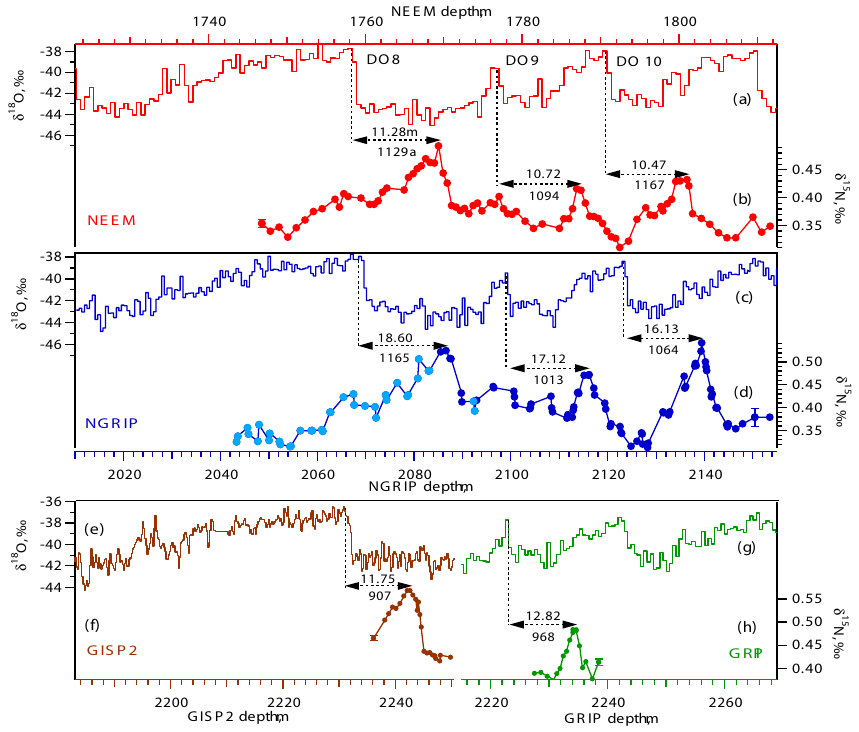
Fig. 2. Water and nitrogen stable isotope data (‰) for NEEM, NGRIP, GISP2 and GRIP. For each δ 15 N data series the associated uncertainty ( ± 1 σ ) is shown. NEEM: (a) δ 18 O bag data (measured along 55cm samples) measured at CIC, this study; (b) δ 15 N data measured at LSCE, this study. NGRIP: (c) δ 18 O bag data, NGRIP members (2004); (d) δ 15 N data measured at the University of Bern. Dark blue: data points from Huber et al. (2006). Light blue: this study. GISP2: (e) δ 18 O bag data, Grootes and Stuiver (1997); (f) δ 15 N data, Orsi et al. (2013). GRIP: (g) δ 18 O 55cm bag data, Johnsen et al. (1992); (h) δ 15 N data measured at LSCE, this study. Table 2. Correspondence between δ 15 N and δ 18 O or accumulation for the NEEM and NGRIP cores (see also ig. A3 and D1). δ 18 O data are averaged over 55cm (bag data) and we use here the depth at the middle of the 55cm interval. The age is given according to the GICC05 timescale. The 1 depth ( 1 age) is obtained by calculating the difference between ice and gas depth (age). The 1 age uncertainty is given by the difference between the MCE at the ice depth and the MCE at the gas